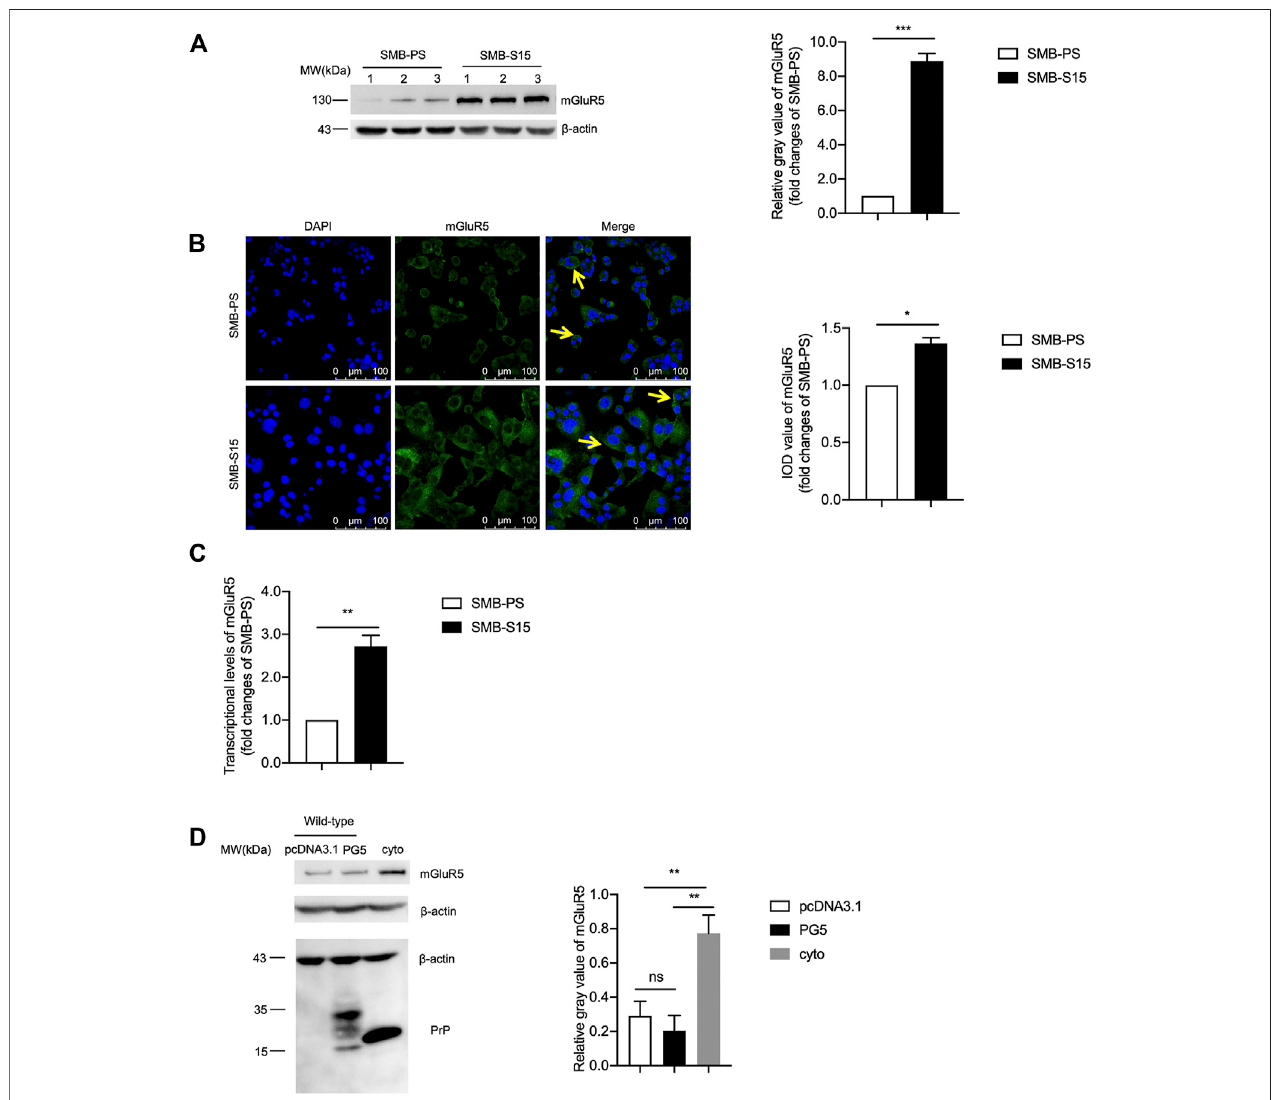
FIGURE 1 | The levels of mGluR5 in a prion-infected cell line and the cells transiently expressing Cyto-PrP. (A) Left: Western blot for the levels of mGluR5 in two SMB cell lines. Relative molecular weights are marked on the left. (1, 2, 3) indicate the number of replicates. Right: Densitometric analyses of the average gray values of thesignalsofthemGluR5afterbeingequilibratedwiththatof β -actin.TherelativegrayvalueofmGluR5inSMB-PScellsissetto1and Y -axisrepresentsthefoldchanges in SMB-S15 versus SMB-PS. (B) Left: Immunocytochemical assays of the distributions of mGluR5 in two SMB cell lines. The images of DAPI (blue), mGluR5 (green),andmerge(yellowarrows)areindicatedabove.TwoSMBcelllinesareindicatedontheleft. Right: TheIODanalysisforthesignalsofmGluR5intheimagesoftwo SMB cell lines. The quantitative results are presented as mean + SEM. The IOD value of mGluR5 in SMB-PS cells is set to 1 and Y -axis represents the fold changes in SMB-S15 versus SMB-PS. (C) Comparative analysis of the levels of mGluR5-speci fi c mRNAs in SMB-PS and -S15 cells by real-time PCR. The transcriptional level of mGluR5-speci fi cmRNAwasdeterminedrelativetothatoftheindividualGAPDH.TherelativeintensityofthetranscriptionsofmGluR5geneinSMB-S15cellsisrelativeto that of SMB-PS cells that is set to 1. (D) Left: Western blot for the levels of mGluR5 in the cells transiently expressing wild-type PrP and Cyto-PrP. Relative molecular weightsaremarkedontheleft. Right: DensitometricanalysesoftheaveragegrayvaluesofthesignalsofthemGluR5afterbeingequilibratedwiththatof β -actin.Dataare representative of three independent